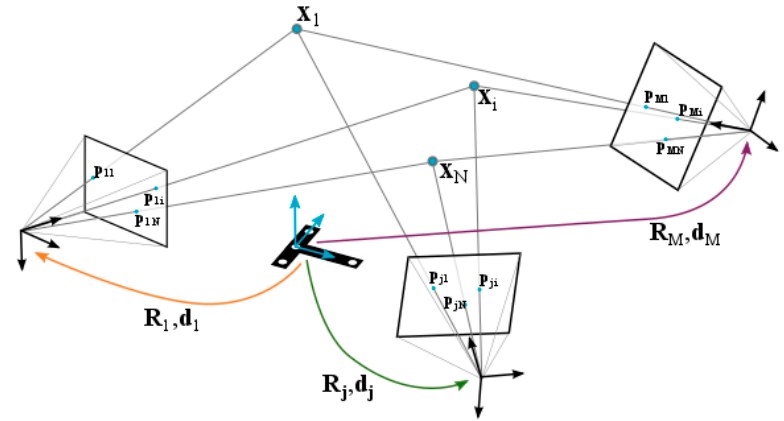
Figure 4. Epipolar ray-net geometry in portable photogrammetry. Camera frame coordinates ( R j and d j ) and optical target 3D coordinates ( X i ) can be expressed with respect to a predefined measuring frame, and computed according to the ray-net corresponding to a set of projected 2D target coordinates ( p ij ) at each image plane.